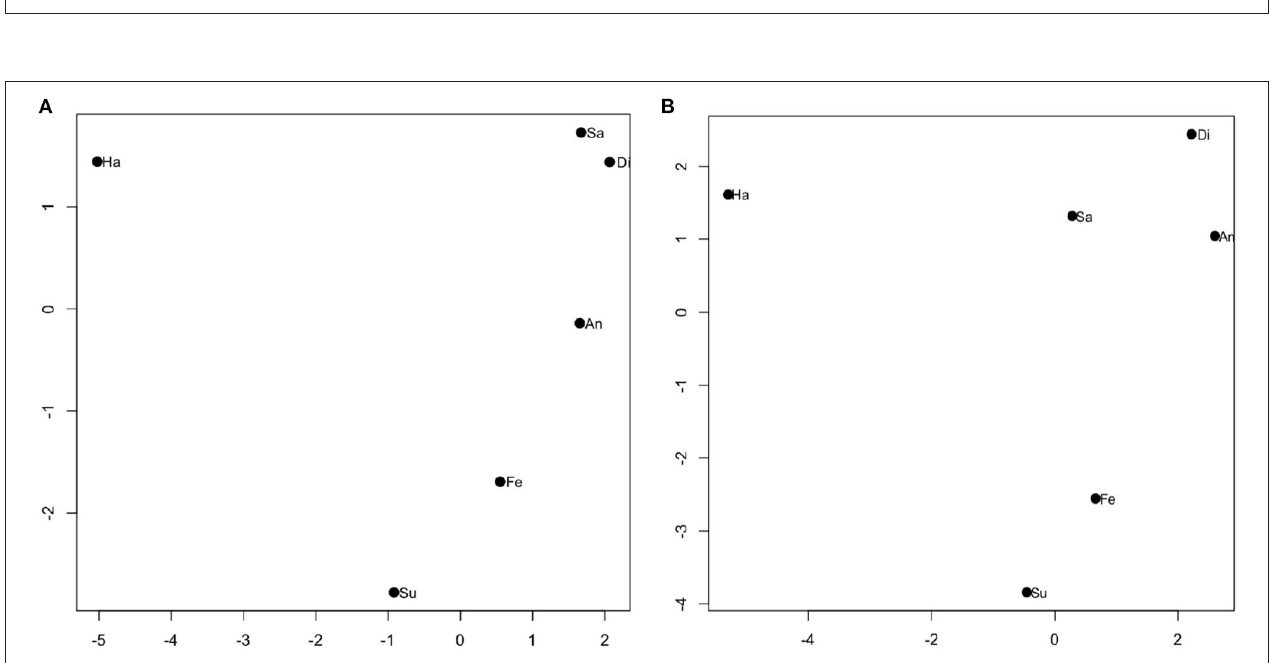
FIGURE 3 | The multidimensional scaling (MDS) solution, based on the discrimination sensitivity (d ′ ) values. The horizontal and vertical coordinates have no special meaning, while the period between the two emotions reflected the discrimination sensitivity value. Di, disgust; An, anger; Fe, fear; Su, surprise; Sa, sadness; Ha, happiness. (A) The discrimination sensitivity values for major depressive disorder (MDD) patients and (B) the discrimination sensitivity values for healthy controls.